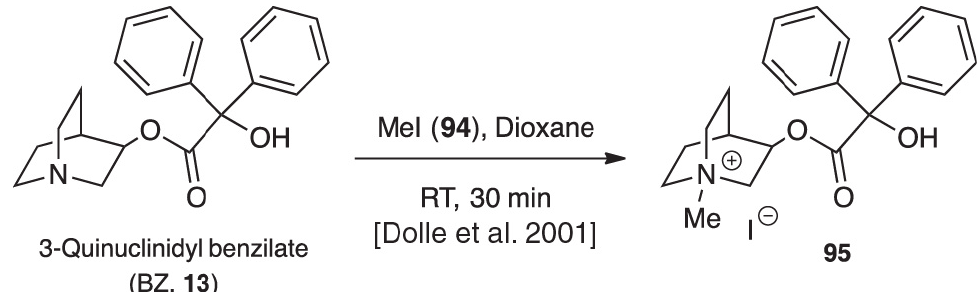
Figure 17: Methylation of BZ resulting in the modification of the nitrogen center to generate BZ-Me salt ( 95 ) suitable for LC-MS applications.